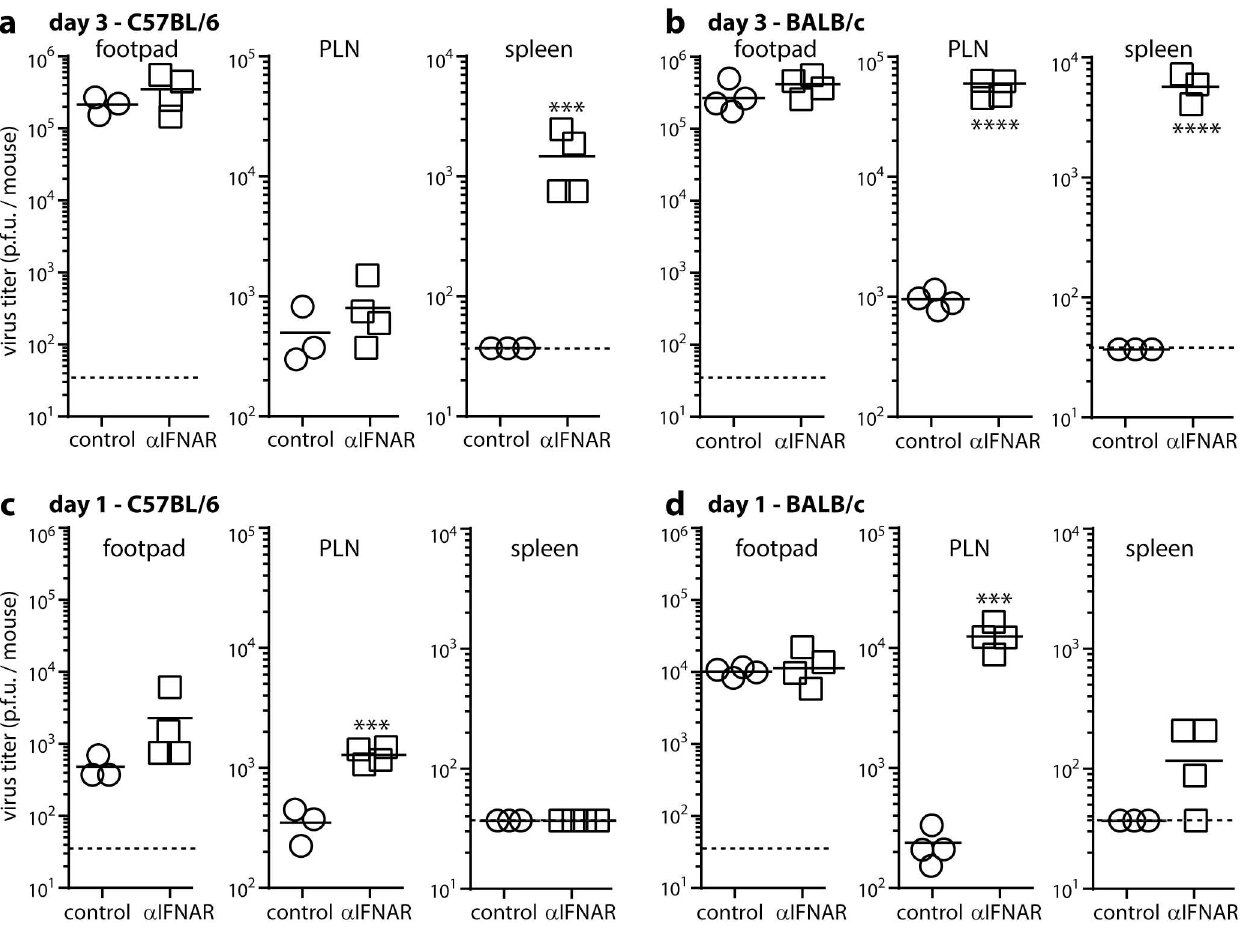
Fig 2. IFNAR blockade increasesearly LN infections of C57BL/6 and BALB/c mice. C57BL/6 ( a , c ) and BALB/c ( b , d ) mice were given IFNAR blockingantibody ( α IFNAR) or not (control) i.p., then MCMV i.f. (10 6 PFU). Infectious virus was plaqueassayed 3 days ( a , b ) or 1 day later ( c , d ). Bars show means, other symbols show individual mice. Dotted lines show assay sensitivity limits. Significant differences were calculated and are indicatedaccordingto the scheme of Fig 1.